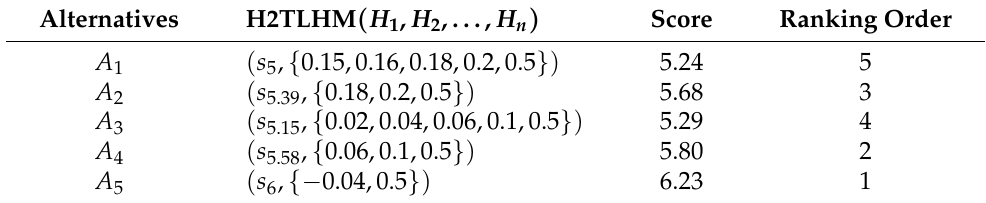
Table 10. Ranking of alternatives by using H2TLHM operator when p = q = 1.